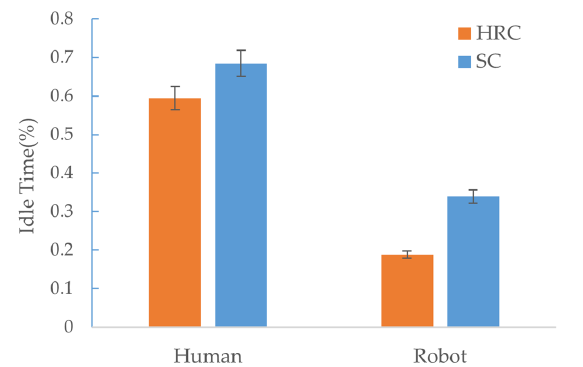
Figure 17. Human idle time and robot idle time comparison between human-robot collaboration with early prediction and speech commanded assistance.